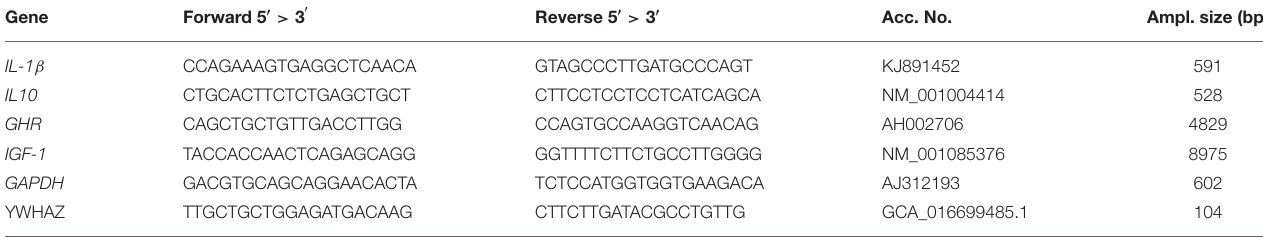
TABLE 3 | The sequence of tested primers applied in real-time PCR analysis. Gene